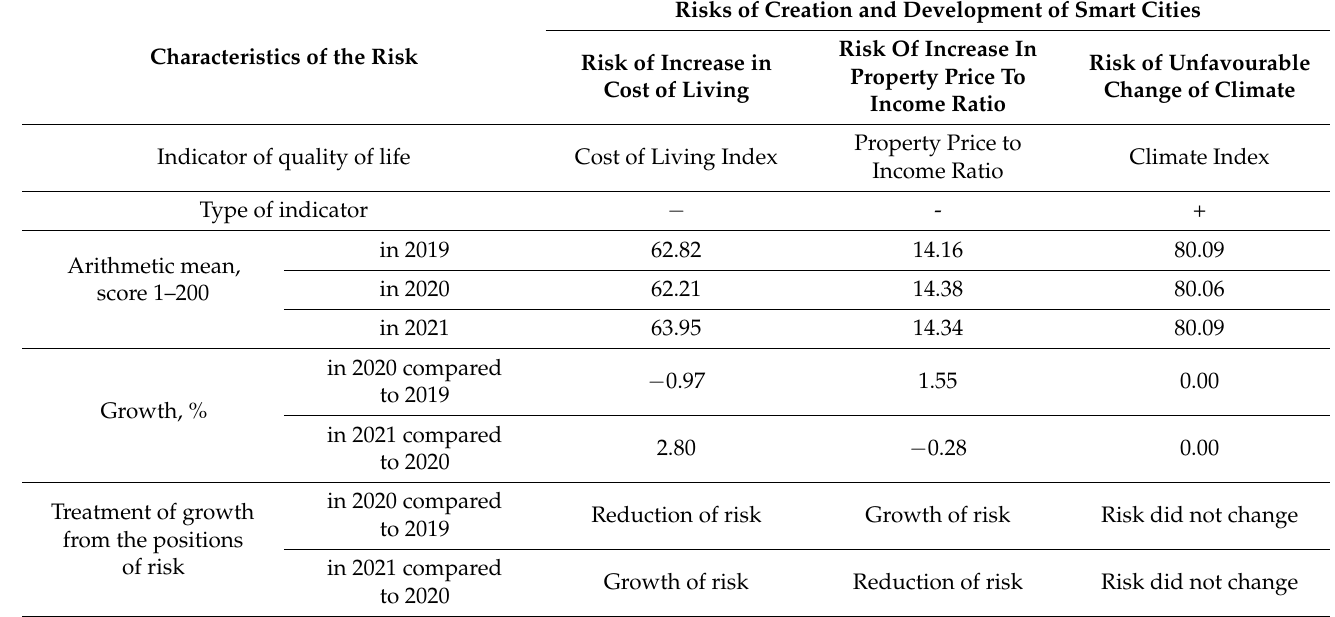
Table 4. Dynamics of change of the risks of creation and development of smart cities in